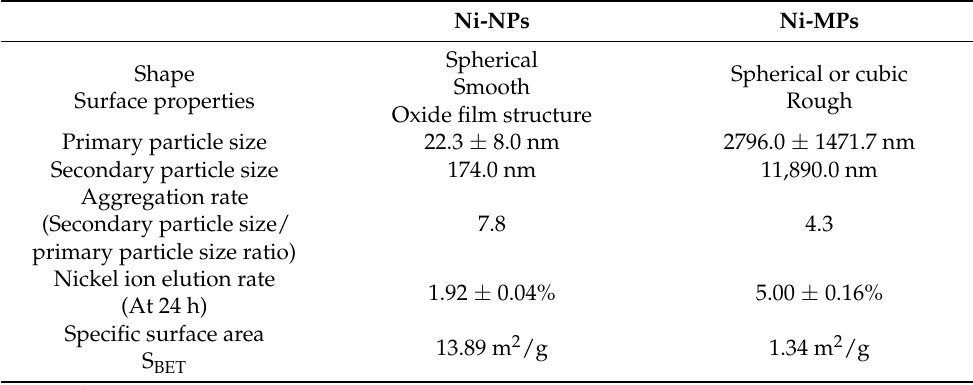
Table 1. Summary of the characteristics of each particle.